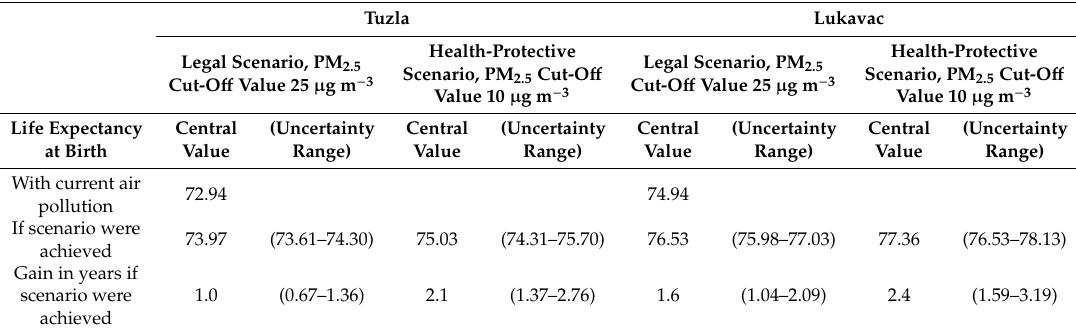
Table 6. Life expectancy (LE) at birth at current PM 2.5 pollution levels and LE against legal and health-protective scenarios.